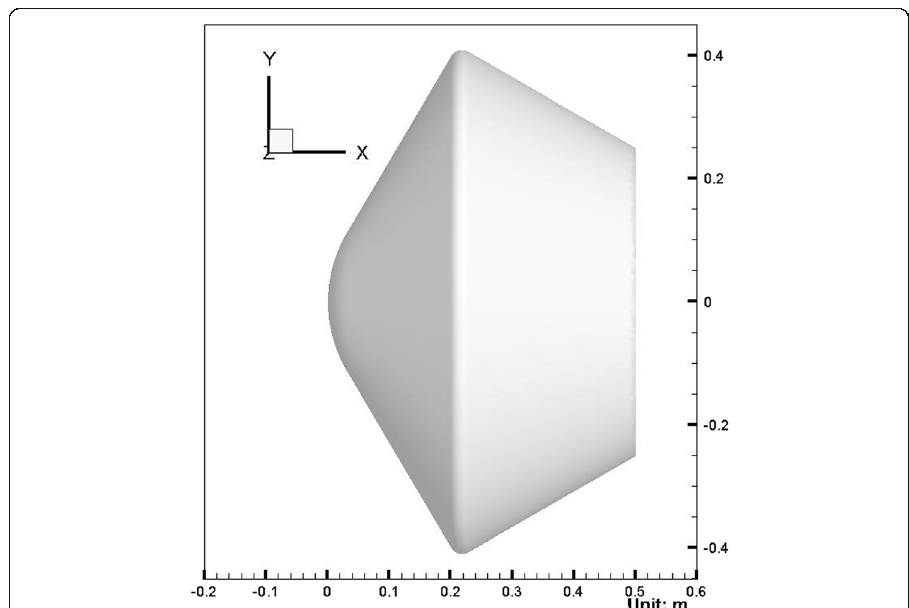
Fig. 10 Configuration of the